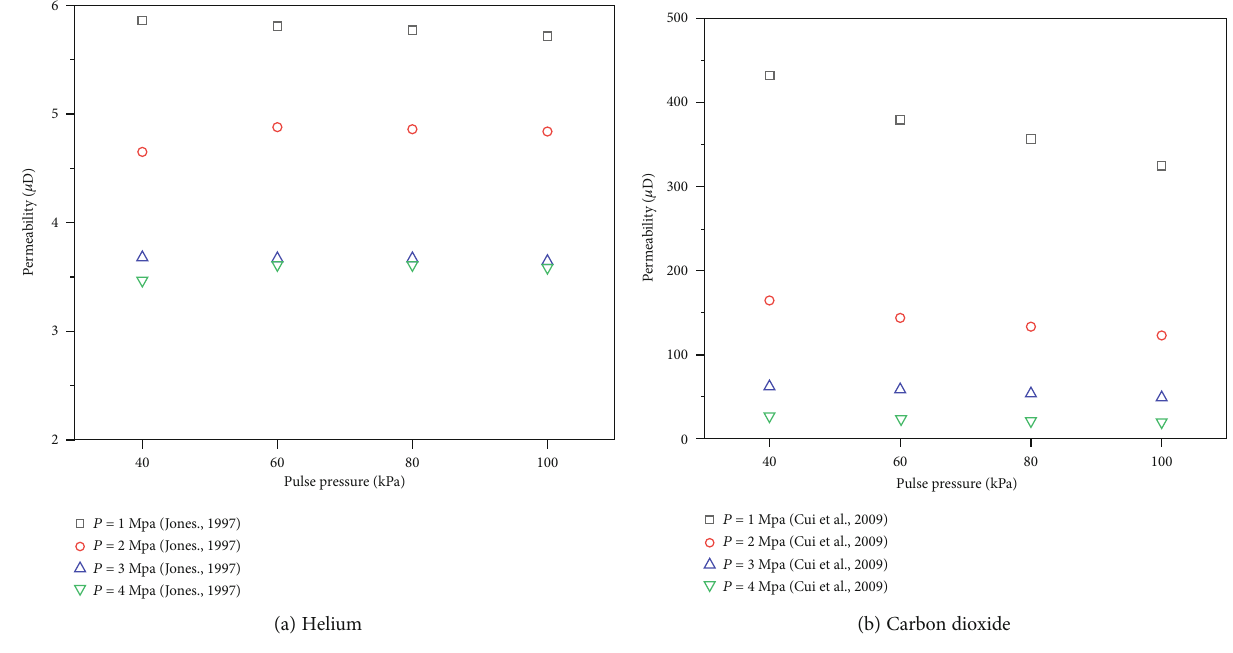
Figure 8: Gas permeability under di ff erent pulse pressures ( netconfining pressure = 3 MPa )